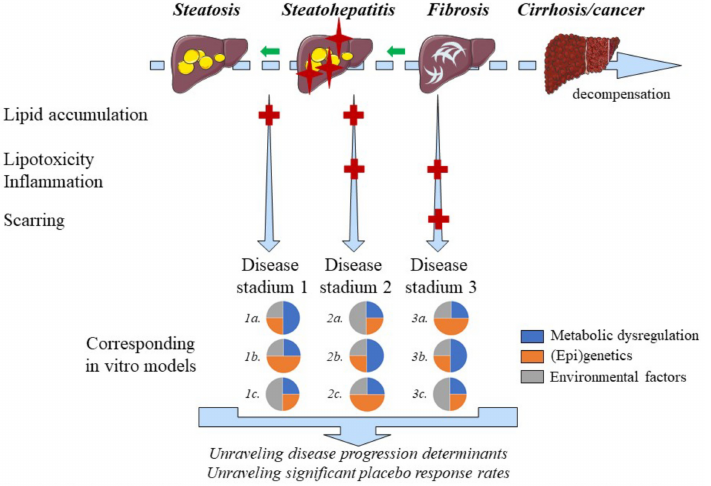
Figure 2. Positioning of MAFLD disease models. MAFLD is a naturally progressing and regressing disease of which different stadia can be accurately modeled in vitro. The main pathogenic drivers, however, differ among patients suffering from MAFLD, which requires multiple disease models for different MAFLD stadia. Steatosis is indicated by yellow ovals whereas red crosses on the liver figures indicate additional inflammation. Light blue fibers indicate hepatic accumulation of extracellular matrix components. The key factors involved in the different stages of MAFLD, mentioned on the left side of the figure, are indicated by corresponding red ‘+’ symbols. Regression of the disease is represented by the green arrows in the decompensation